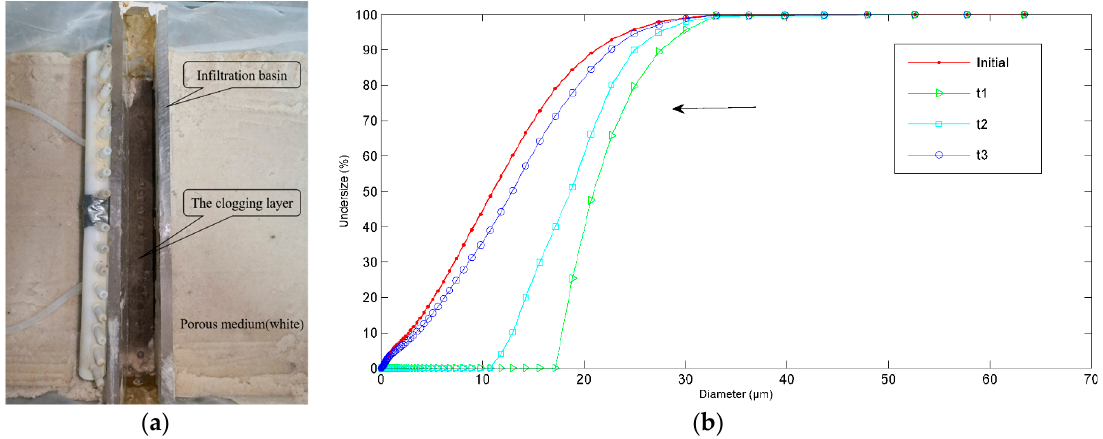
Figure 5. ( a ) Dark clogging layer at the end of experiment relative to the white porous medium. ( b ) Characterization of the PSD of the SP retained on the basin bottom at different times (t 1 , t 2 and t 3 ) during the experiment under constant head. The initial PSD of injected SP is also represented with a red line.